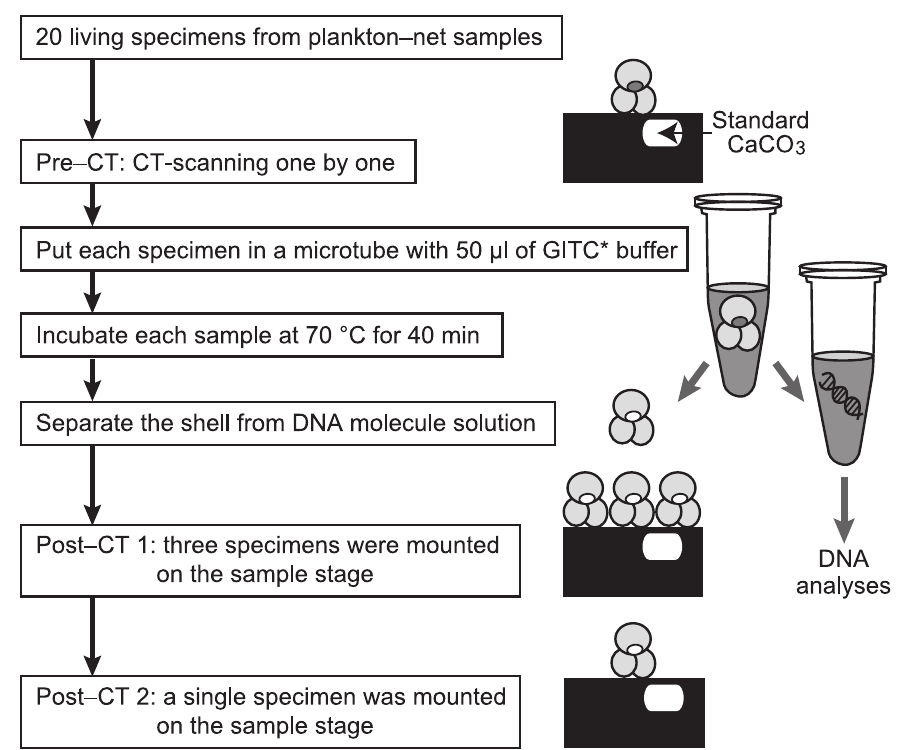
Fig 1. Analytical flowchart for the micro-focus X-ray computed tomography (MXCT) scanning method combined with genetic analyses. Pre- and Post-computed tomography (CT) show MXCT scanning before incubating shells in the DNA extraction buffer (modified guanidine isothiocyanate (GITC � ) buffer) and after. Post-CT 1 and Post-CT 2 show different mounting of specimens on the sample stage.